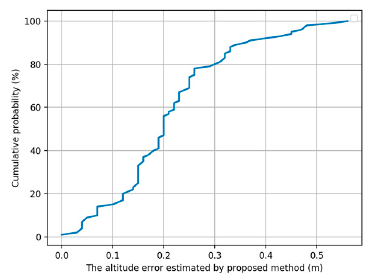
Figure 13. The cumulative probability of the altitude error estimated by our proposed method in the intermediate areas between floors.